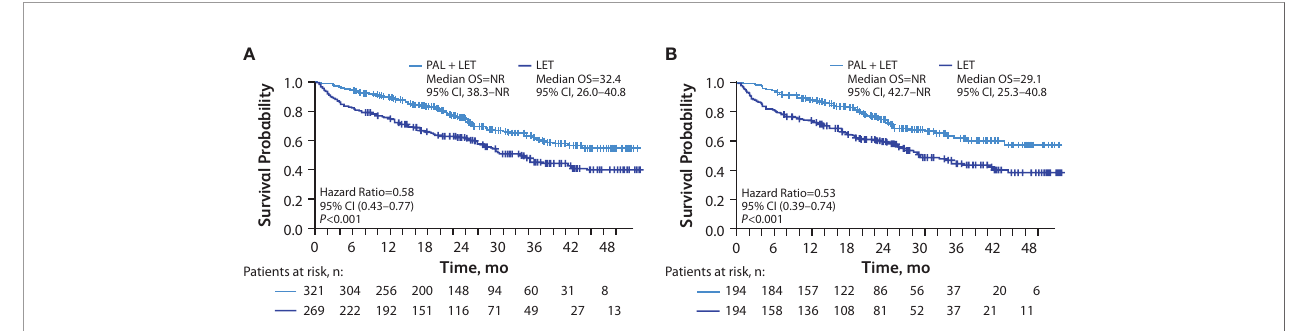
FIGURE 2 | Kaplan-Meier curves of overall survival in patients with visceral (lung and/or liver) metastasis. sIPTW analysis (A) and PSM analysis (B) ; number of patients at risk are shown. LET, letrozole; NR, not reached; OS, overall survival; PAL, palbociclib; PSM, propensity score matching; sIPTW, stabilized inverse probability treatment